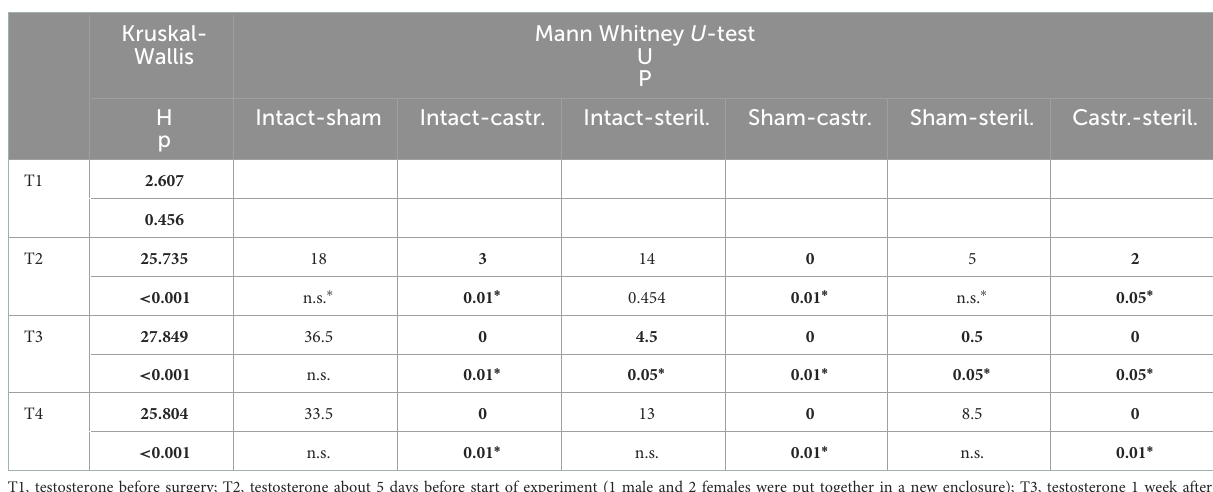
Mann Whitney U -test U P